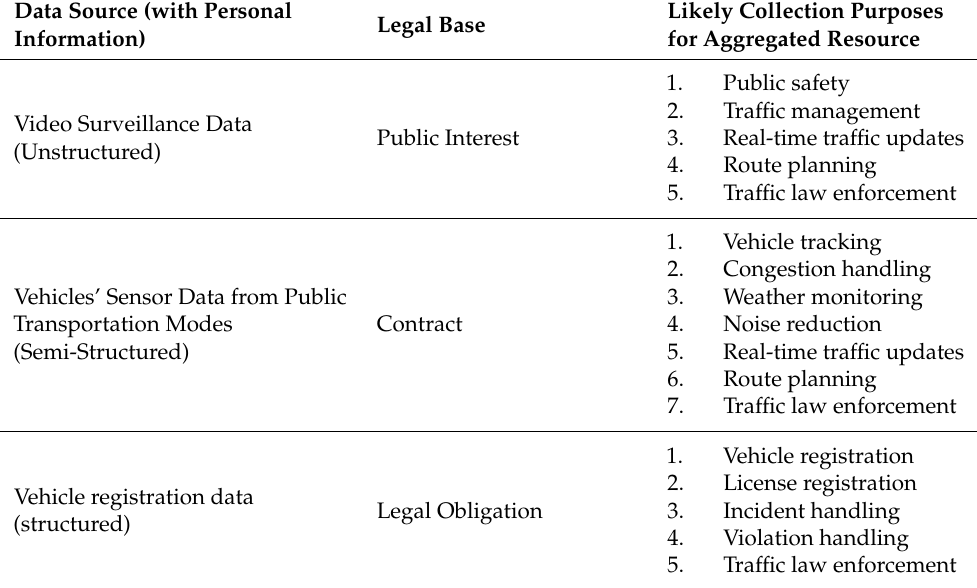
Table 1. Data collection purposes and legal